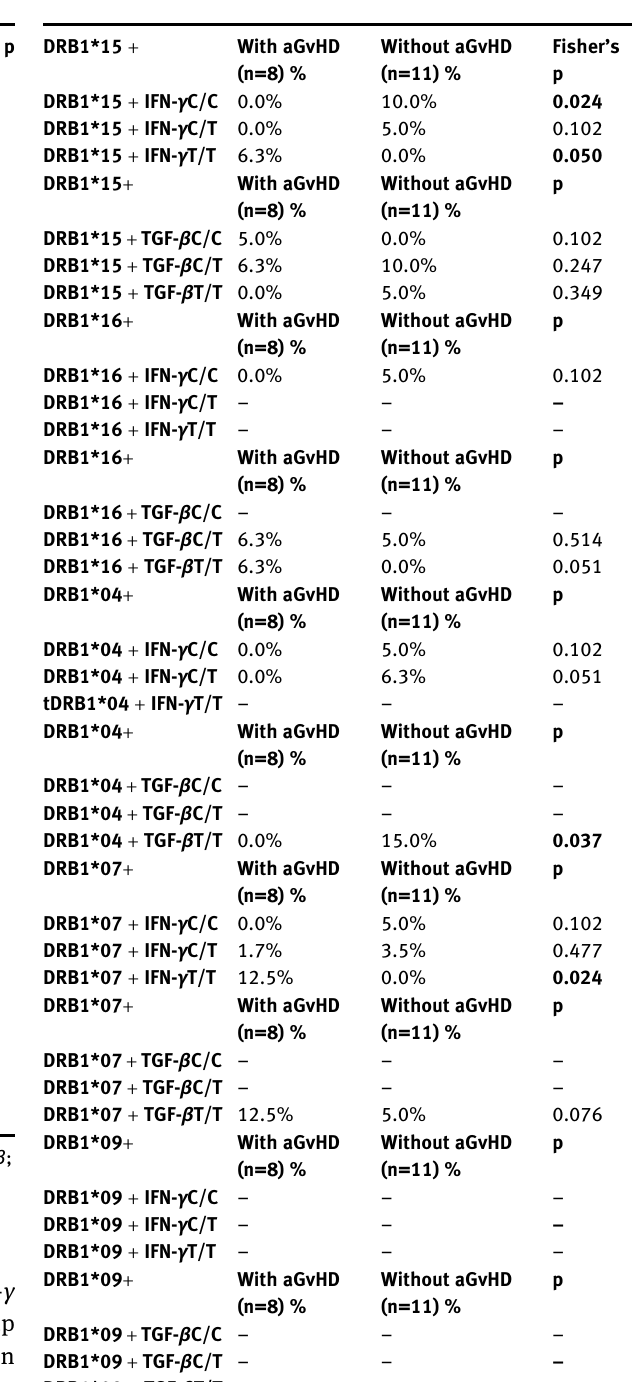
Table  : HLA-DRB  *  ,  ,  ,  ,  alleles of the patients, and the correlation with TGF- β , IFN- γ variations between the subjects with and without